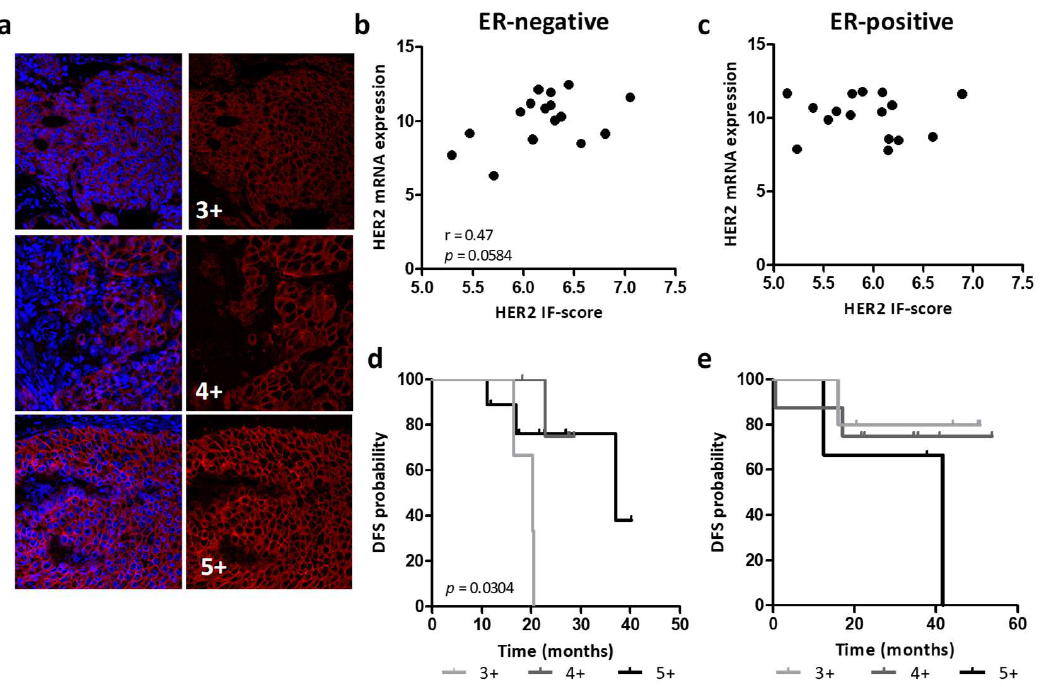
Figure 2. Association between HER2 protein expression and patient prognosis . ( a ) Representative images of HER2 positivity (red) by IF are shown. Images were analyzed using the same parameters. Tumors were scored as 3+ (1st tertile), 4+ (2nd tertile) and 5+ (3rd tertile) according to the mean fluorescence intensities of positive pixels. Nuclei were stained with DAPI (blue). ( b , c ) Association between HER2 mRNA expression levels (log2) and protein levels determined according to HER2 IF-score (log2) in ER-negative ( b ) and ER-positive ( c ) subgroups. The Pearson coefficient and relative p value are shown. ( d , e ) Kaplan‒Meier analysis of ER-negative (n = 17, d ) and ER-positive (n = 16, e ) patients classified according to the HER2 IF-score. p value determined by log-rank test.